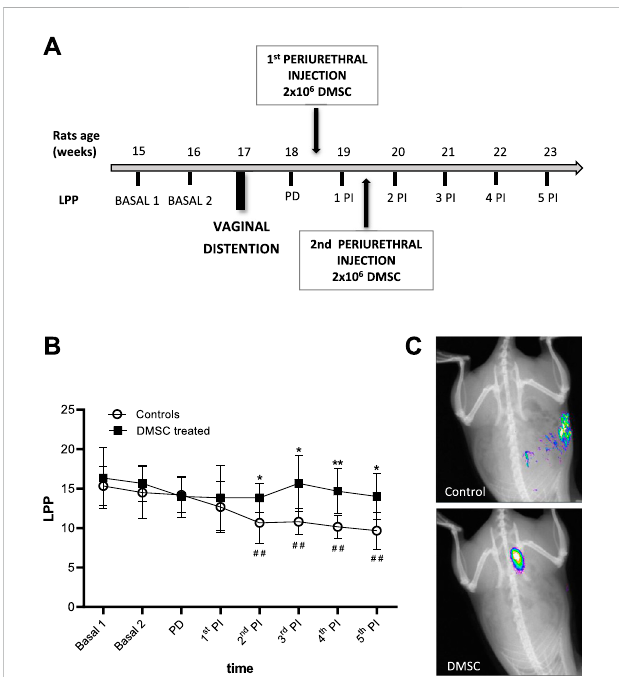
abdominal leakpoint pressure(LPP)orenhancedLPPinratsaftervaginal distention (VD). (A) Flowchart of the design of measurement of LPP, vaginal distentionandtreatmentwith DMSC.Basal 1and Basal2are LPP measurements from the 2 weeks prior to VD. Post-damage (PD)